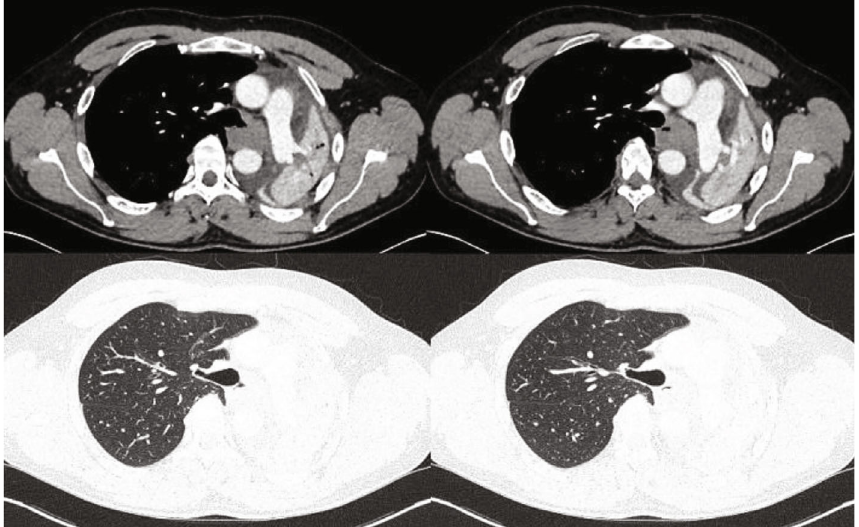
Figure 2: CT scan fi ndings before the surgical procedure: a mediastinal gangliotumoral complex obstructing the left main bronchus, invasion of the carina and the lower trachea with an ipsilateral pulmonary collapse.